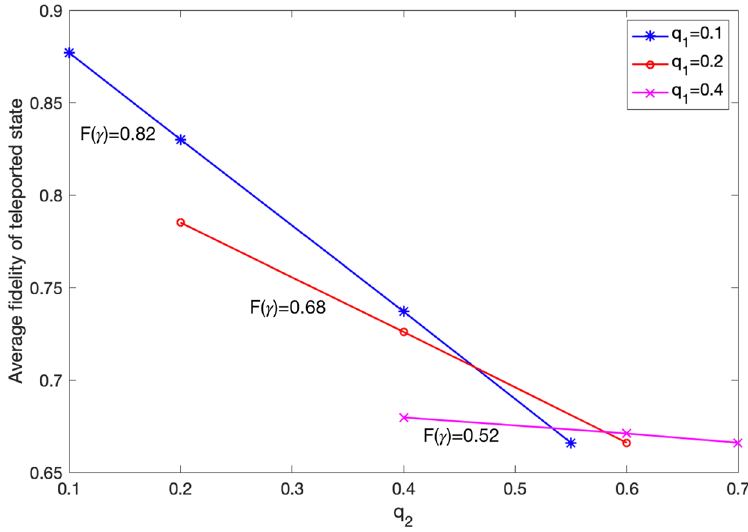
Figure 4. Average fidelity of the teleported state for different values of q 1 and q 2